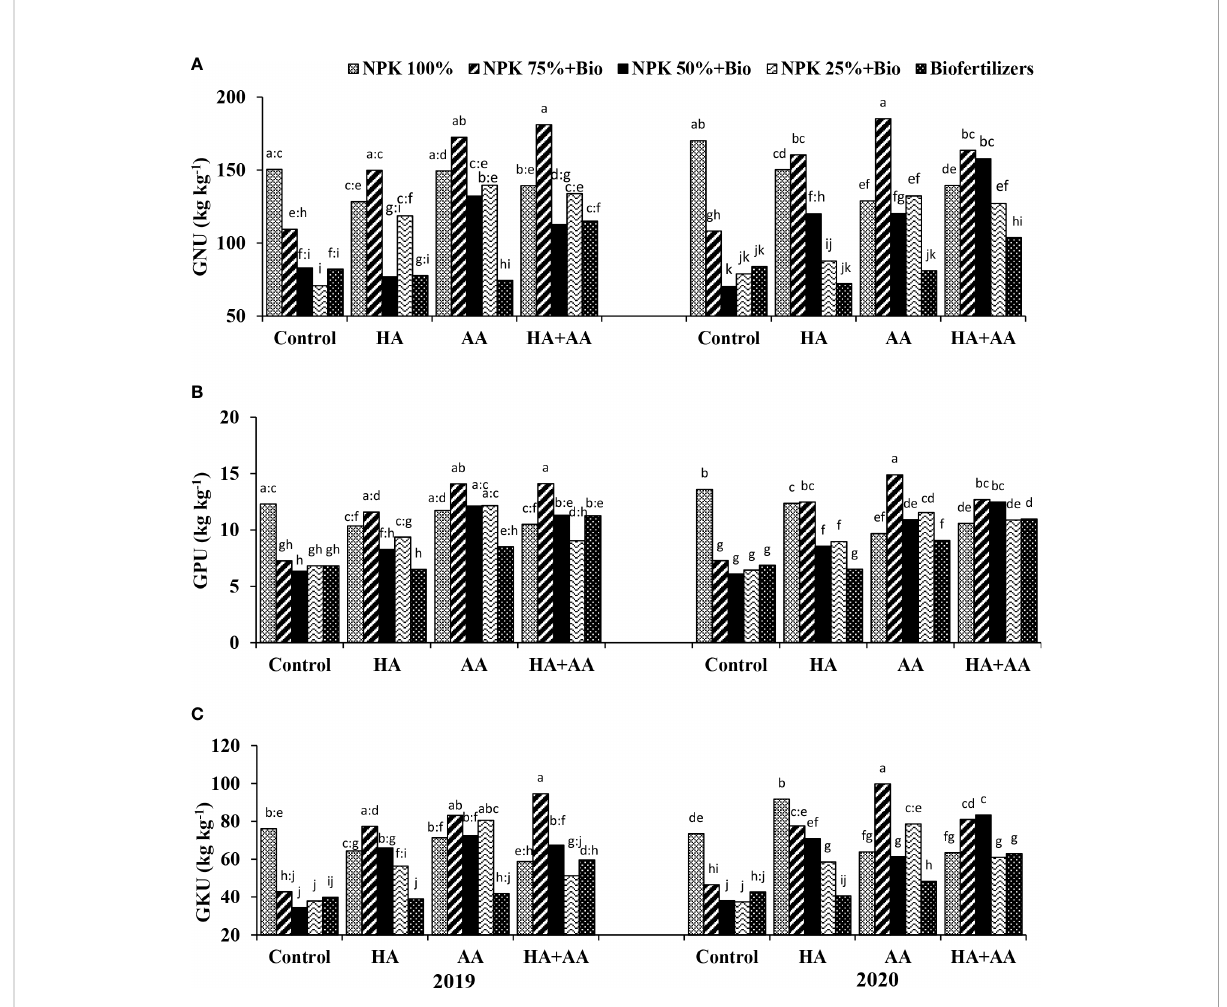
FIGURE 2 Impact of humic acid (HA), amino acids (AA) and the mixture (HA+AA) application on grain nitrogen uptake (GNU) (A) , grain phosphorus uptake (GPU) (B) and grain potassium uptake (GKU) (C) under fi ve fertilization treatments. Letters above columns refer to the signi fi cance LSD (p ≤